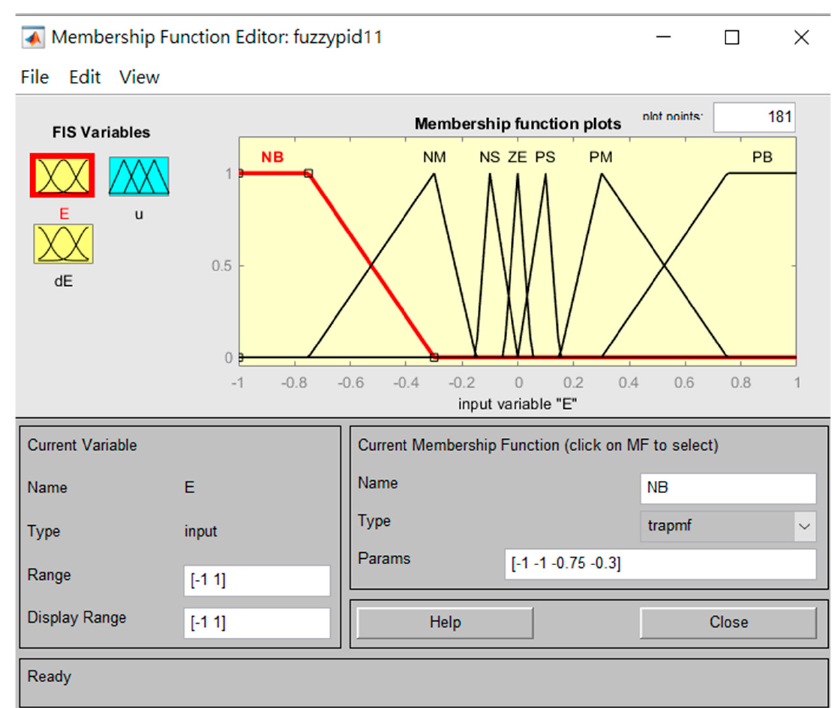
Figure 8. Fuzzy inference block.